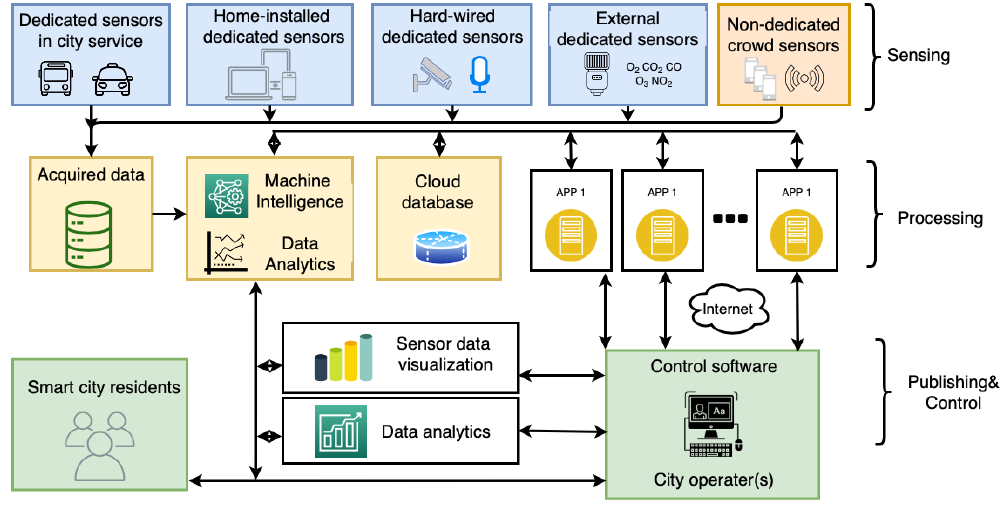
Figure 1. Smart City Sensing Ecosystem